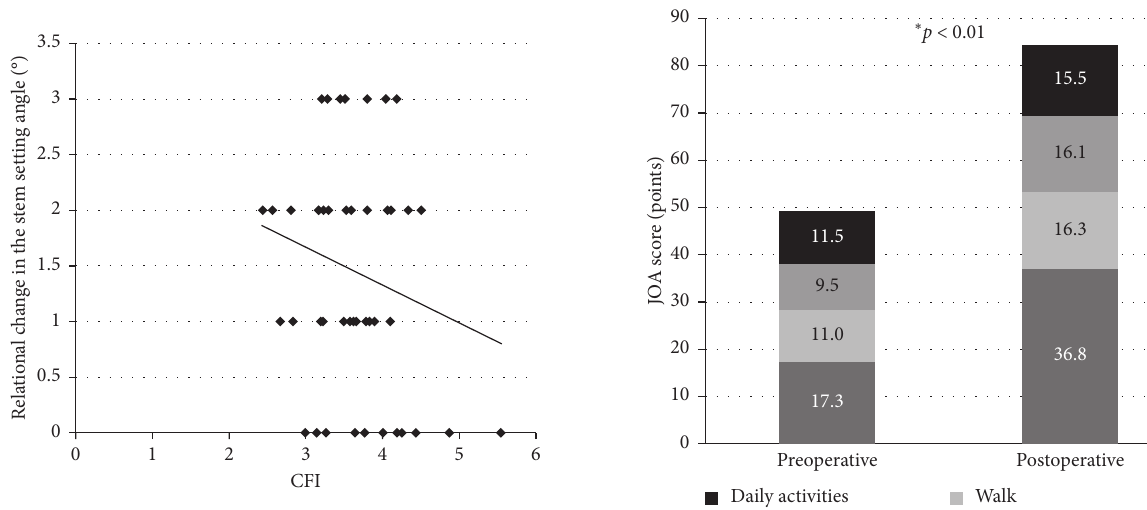
Figure 3: Correlation between the CFI and rotational change in the stem setting angle. There is no significant correlation between the CFI and rotational change in the stem setting angle ( r � − 0.21, p � 0 . 2338, Spearman’s rank correlation coefficient).